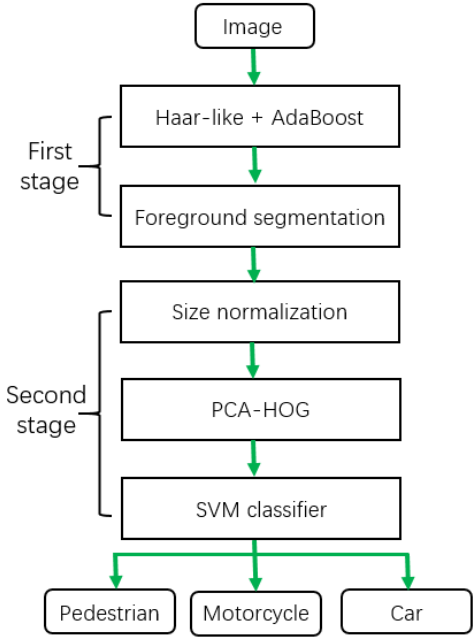
Figure 6. Vision-based object recognition subsystem.